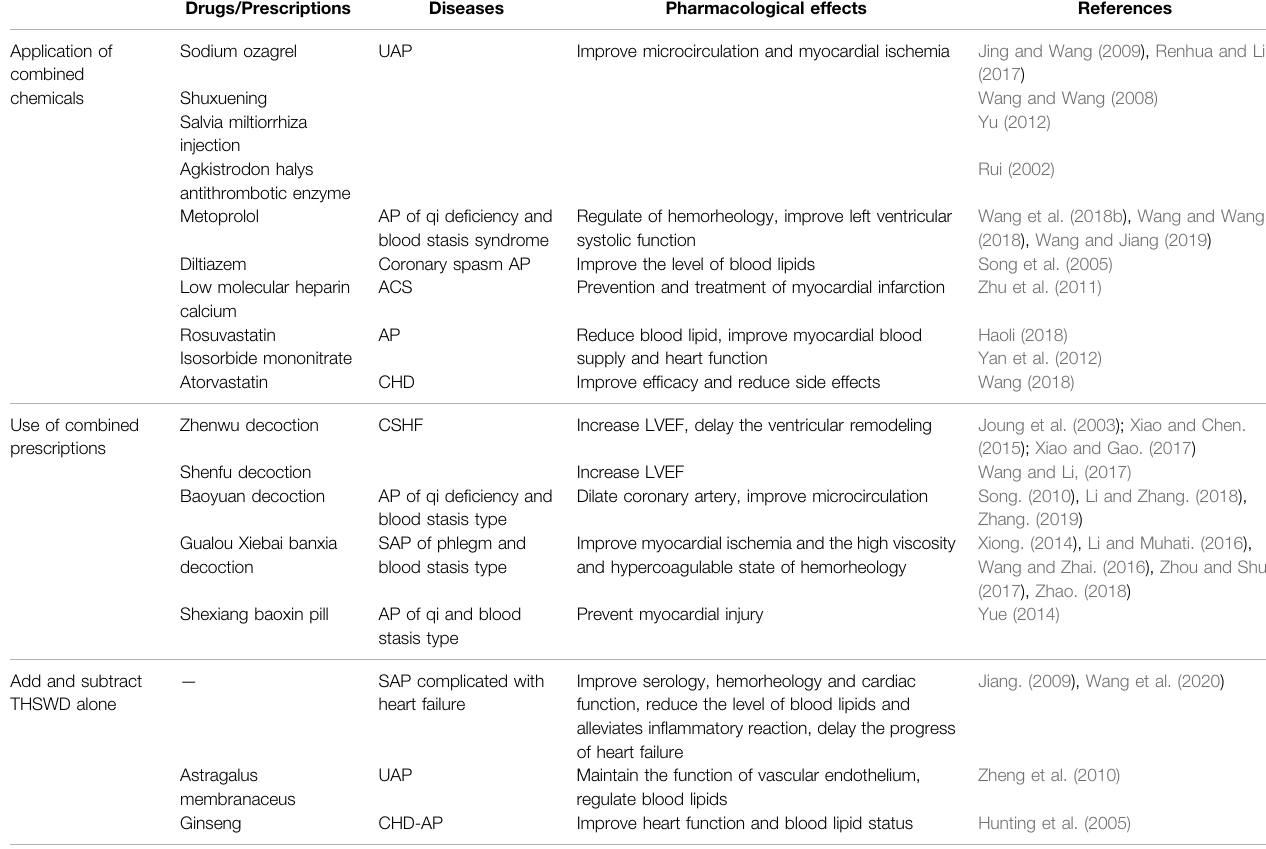
TABLE 1 | Clinical applications of THSWD in prevention and treatment of